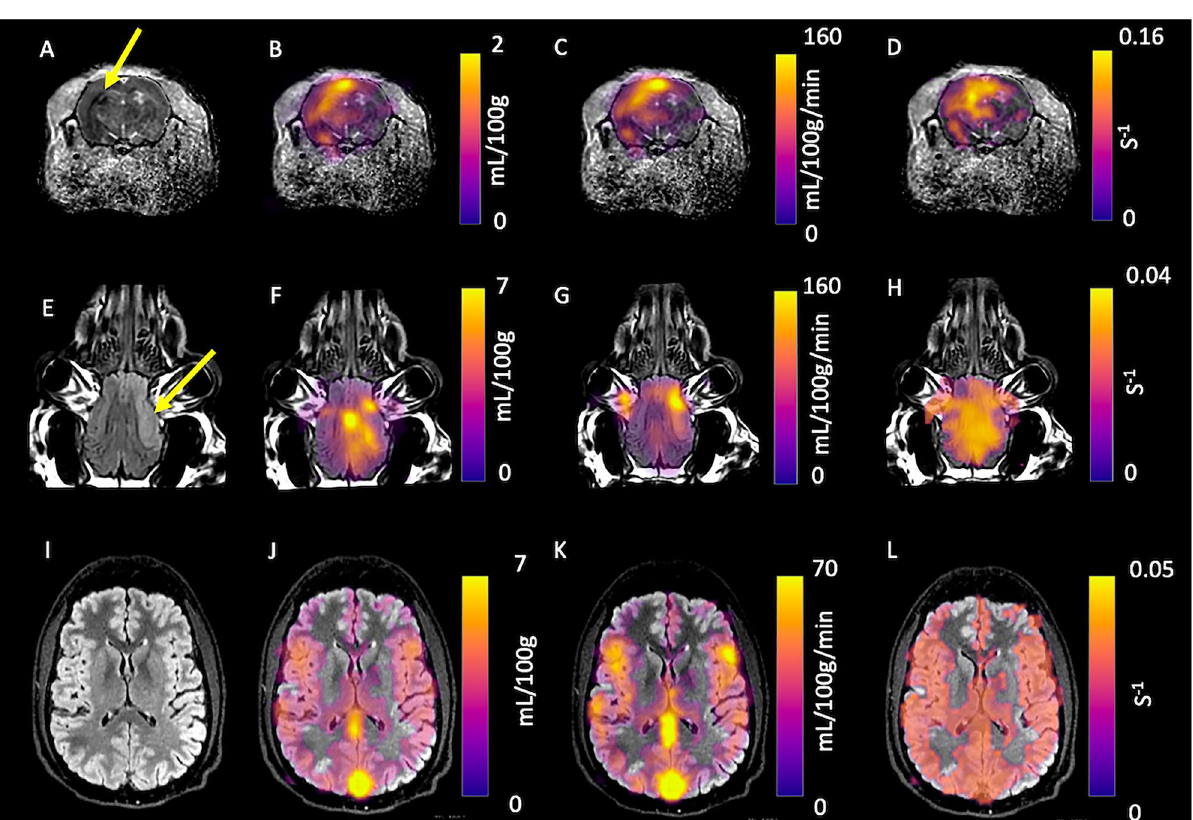
Figure 8. Parametric mapping demonstrated in a rodent and procine models of stroke. The lesion (denoted by the yellow arrow on Apparent Diffusion Coefficient ( A ) and T 2 FLAIR weighted imaging ( E ), with CBV ( B and F , respectively), CBF ( C and G , respectively), and MCR ( D and H , respectively). Also, parametric mapping of the healthy human brain is shown: T 2 FLAIR ( I ), CBV ( J ), CBF ( K ), and MCR ( L